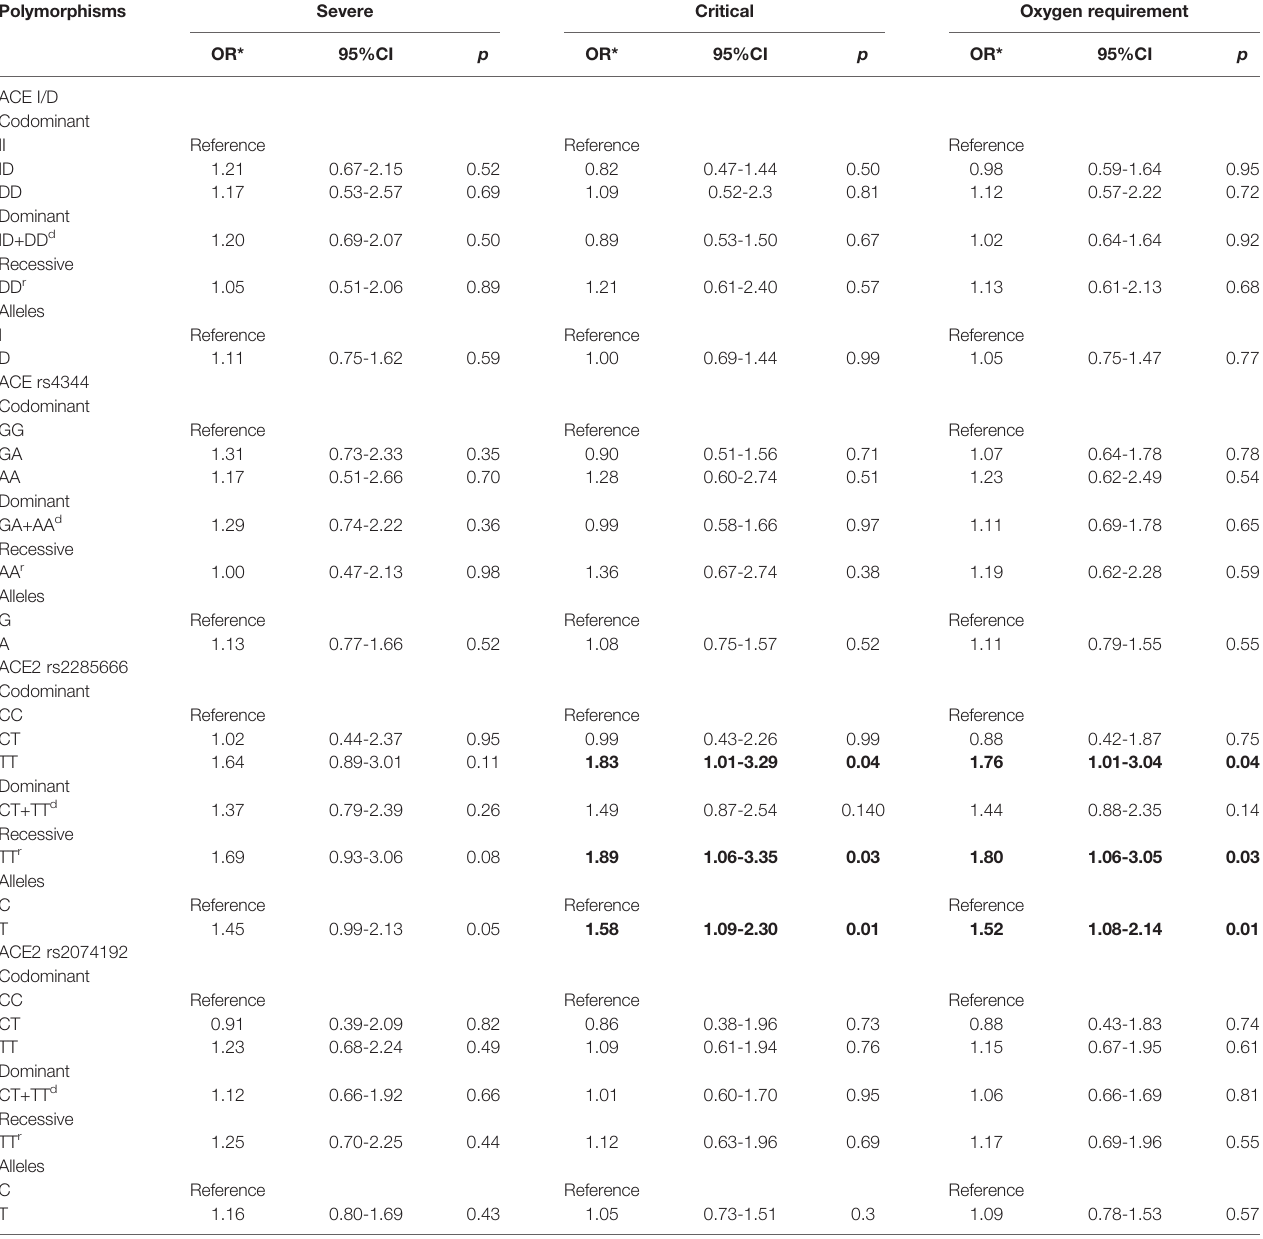
TABLE 3 | Association of ACE and ACE2 polymorphism with the outcome of COVID-19. Polymorphisms Severe Critical Oxygen requirement